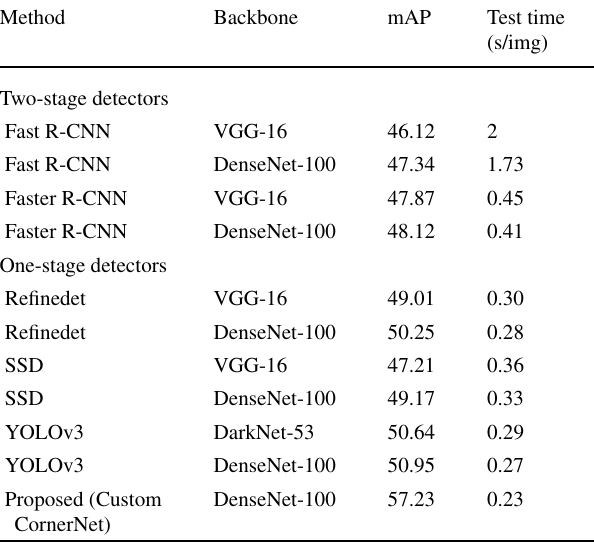
Table 7 Performance comparison of the proposed approach with other object detection methods Method